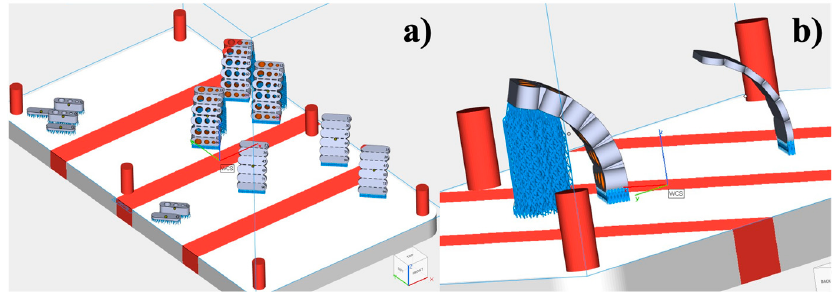
Figure 2. ( a ) Layout of the structures on the building platform of the L-PBF machine and ( b ) detail of the applied support structures.